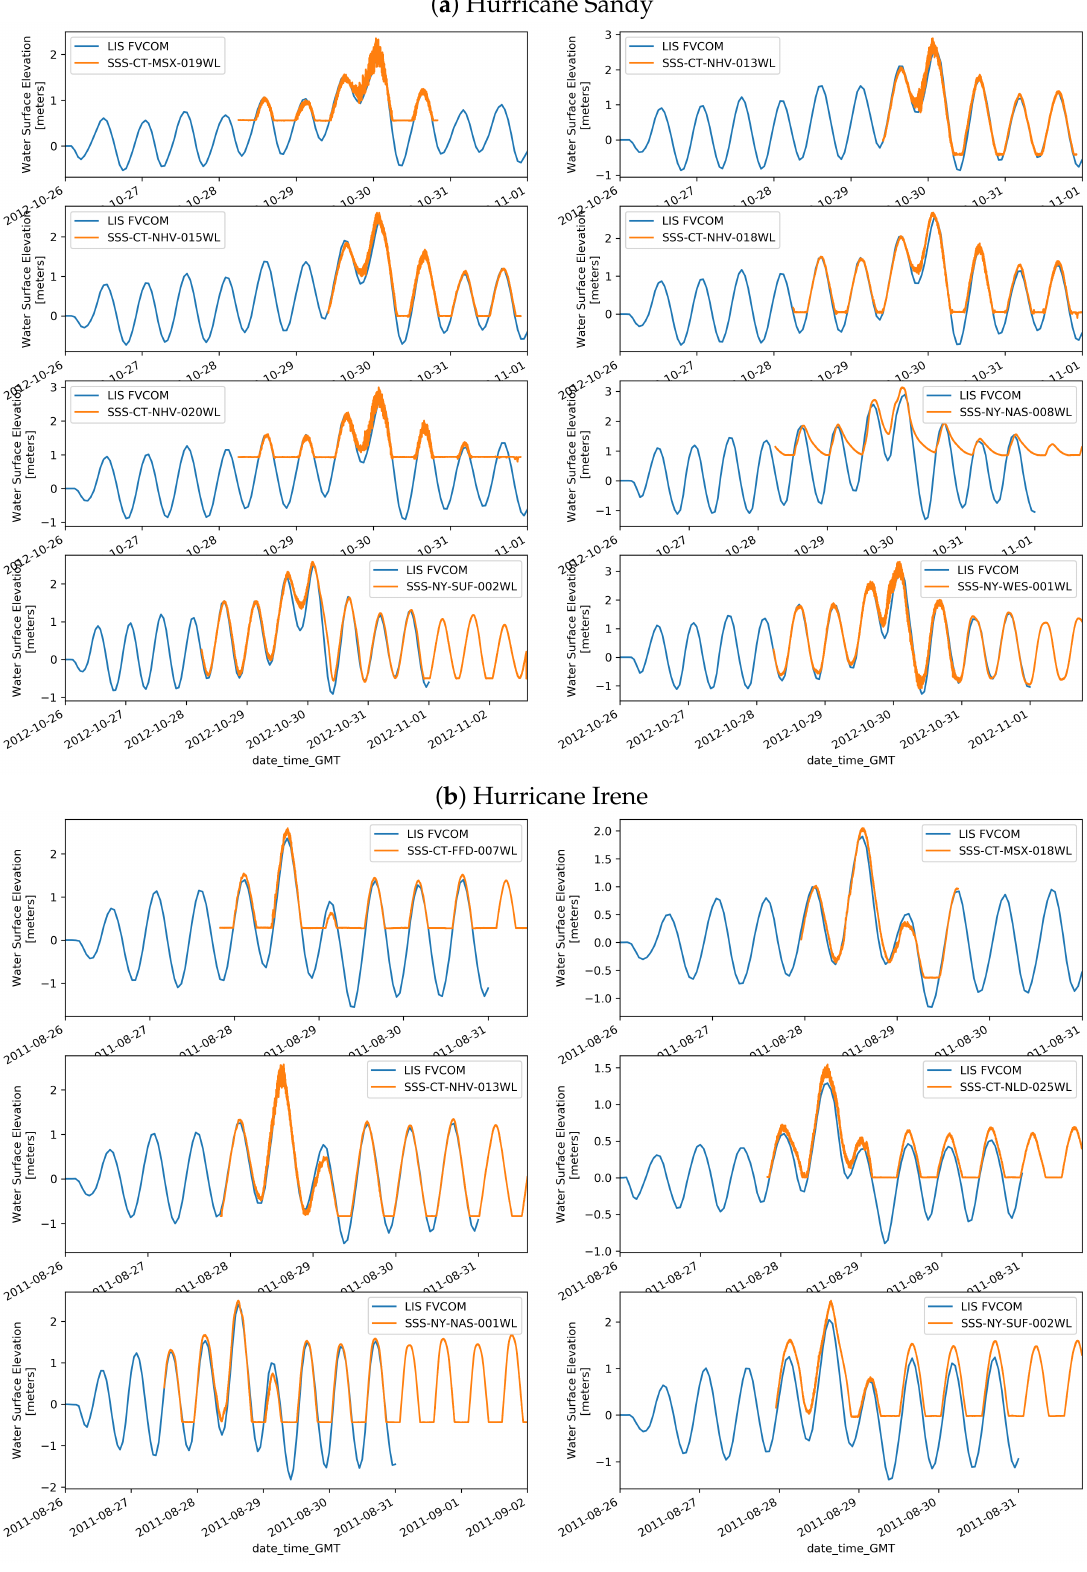
Figure 3. Comparison of water level time series between model (blue) and storm surge sensors from USGS (orange) during hurricane Sandy ( a ) and Irene ( b